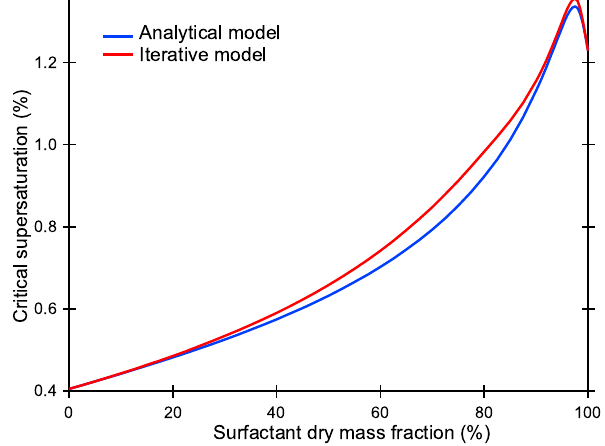
Fig. 4. Critical supersaturation for 40nm SDS-NaCl particles as a function of dry particle surfactant mass fraction. Model predictions are made with the analytical and iterative models with sodium decanoate-NaCl surface tension parameterization (Prisle et al., 2010).